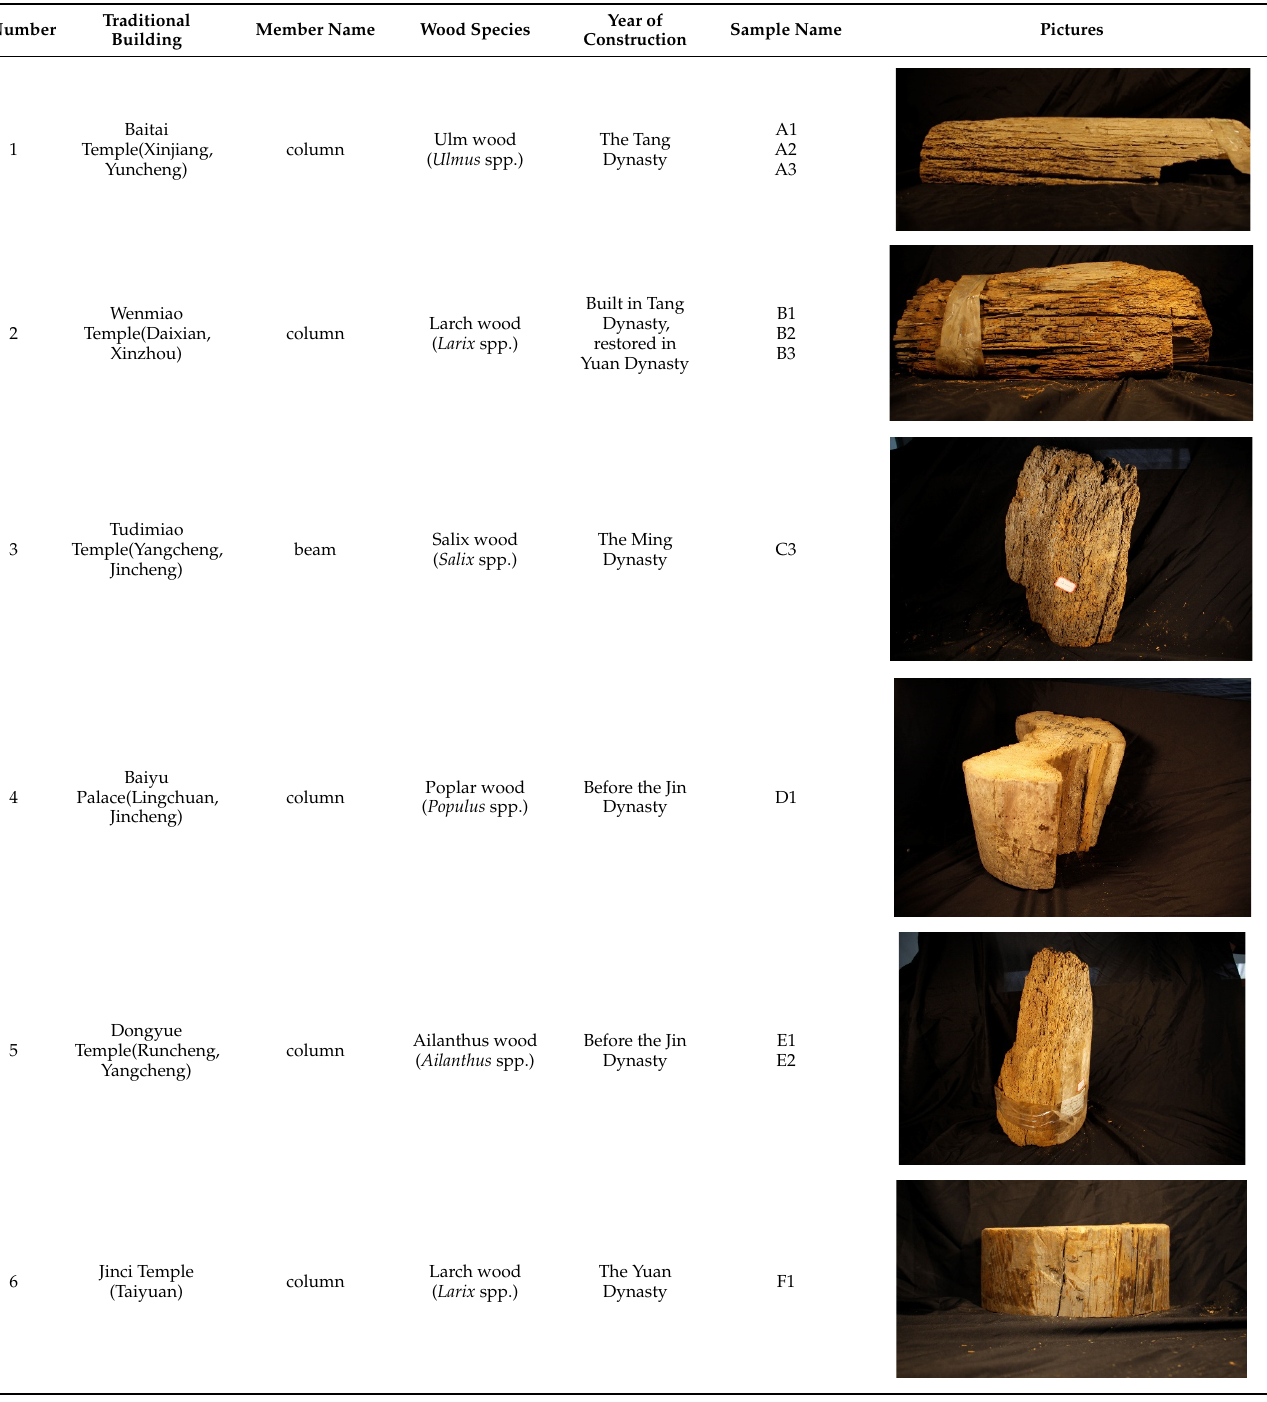
Table 2. Density of the specimen.